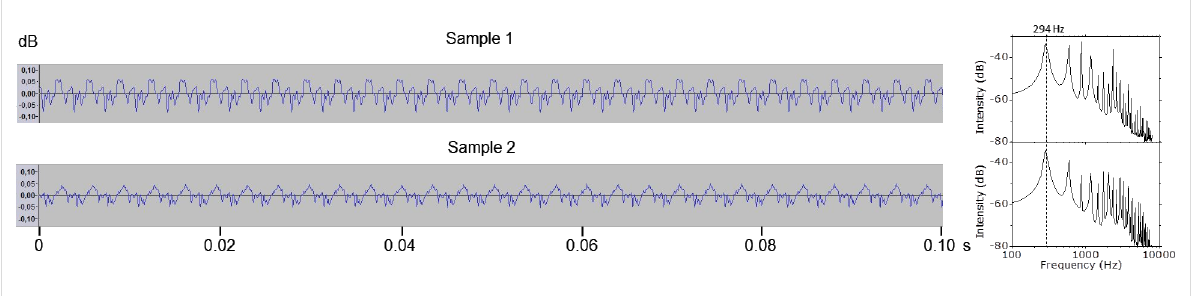
Figure 2: Sound waves and Fourier analyses of samples 1 and 2 with rosin particles.